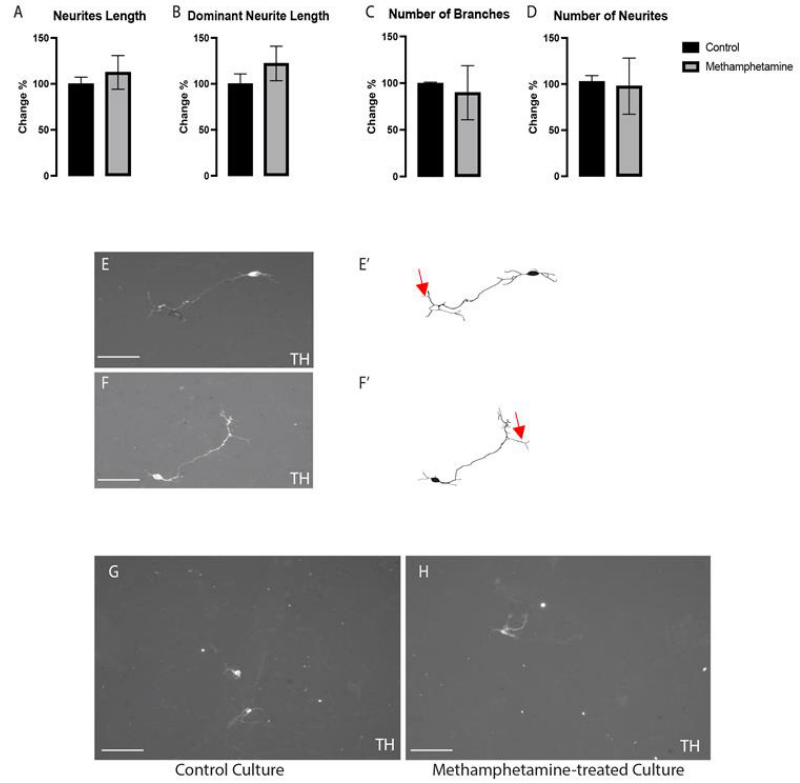
Figure 3. Effects of methamphetamine on neurite length ( A ), dominant neurite length ( B ), branch number ( C ), and neurite number ( D ). Representative photos and illustrations of VMDNs immunolabeled with tyrosine hydroxylase (TH) in control ( E , E’ ) and methamphetamine-treated ( F , F’ ) cultures. ( G , H ) Images show a large field of view (20×) for both groups: control and methamphetamine treated-cultures, respectively.; n = three technical replicates and four biological replicates. Data are shown as the mean ± standard error of the mean (SEM). Data were analyzed using a t -test. Scale bar = 50 µ m ( E , F ). Scale bar = 10 µ m ( G , H ). Red arrows show examples of